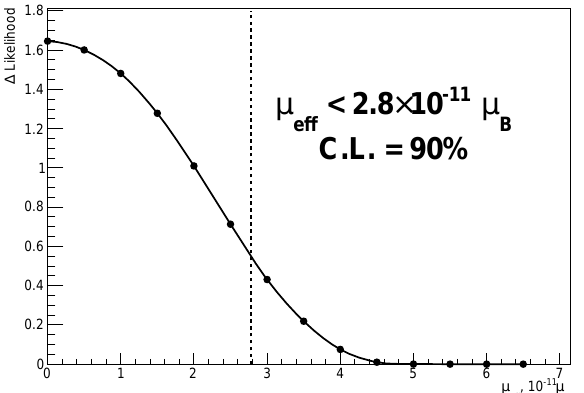
Figure 13. Limit on a possible anomalous effective neutrino magnetic moment with Borexino Phase II solar neutrino data: weighted likelihood profile for the neutrino effective magnetic moment, including systematic effects. The limit corresponds to 90% of the total area under the curve. From